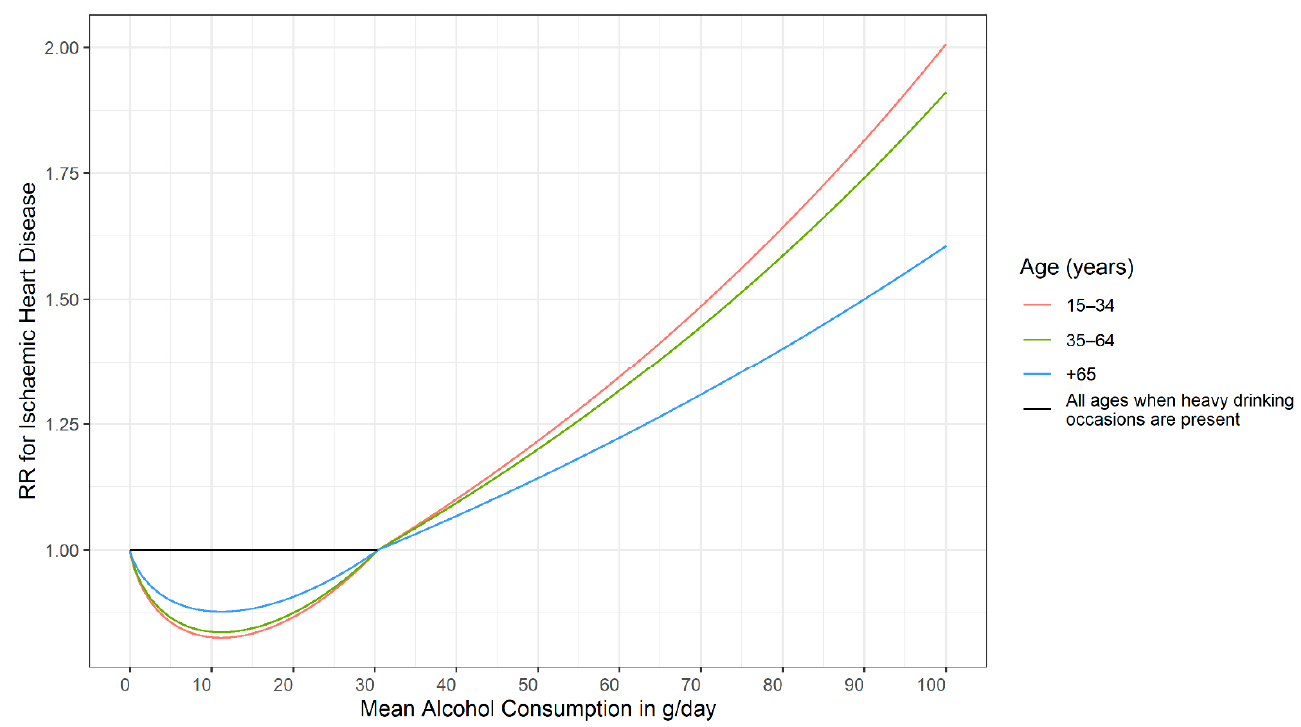
Figure 2. Relative risk for ischemic heart disease mortality as a function of mean alcohol consumption, heavy drinking occasion status, and age for women assuming no heavy drinking occasions for light to moderate drinkers [46]. RR: Relative Risk.